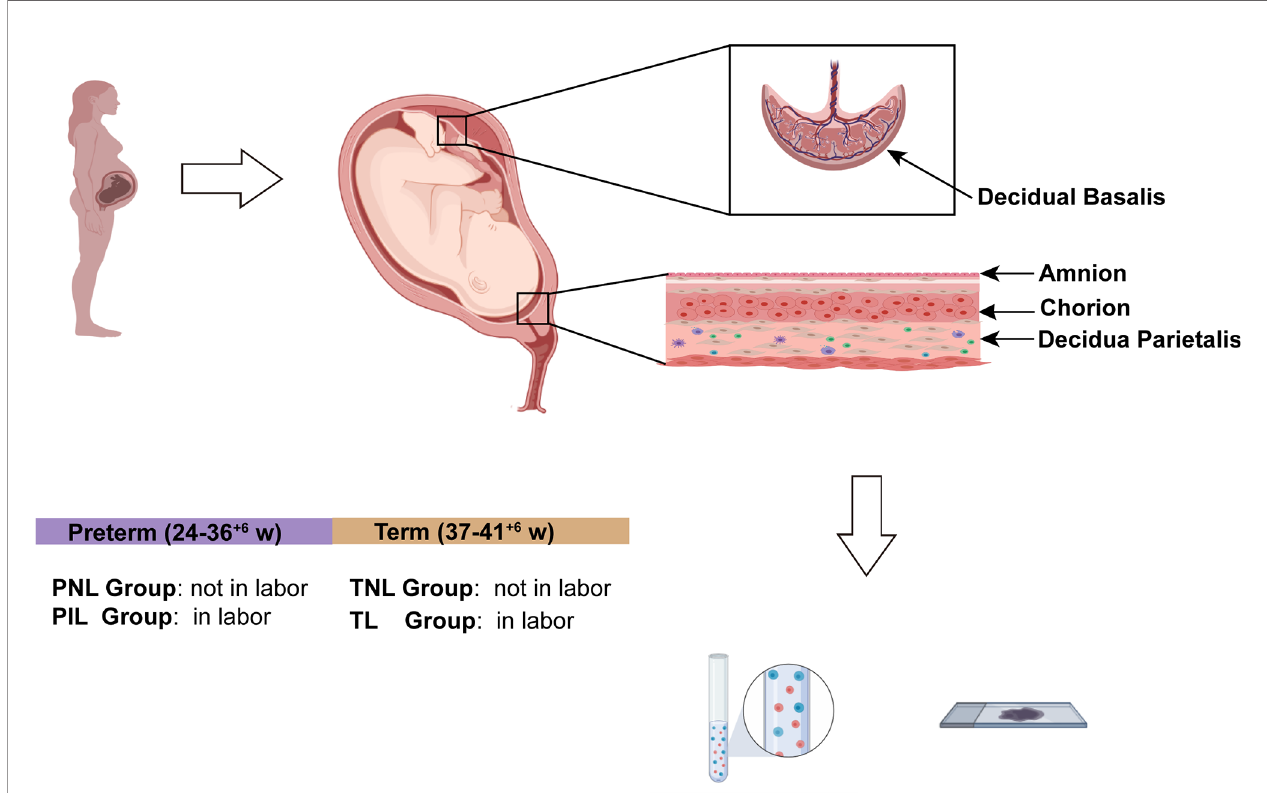
FIGURE 1 | Study Design of the Experiment. The fi gure was created with BioRender.com